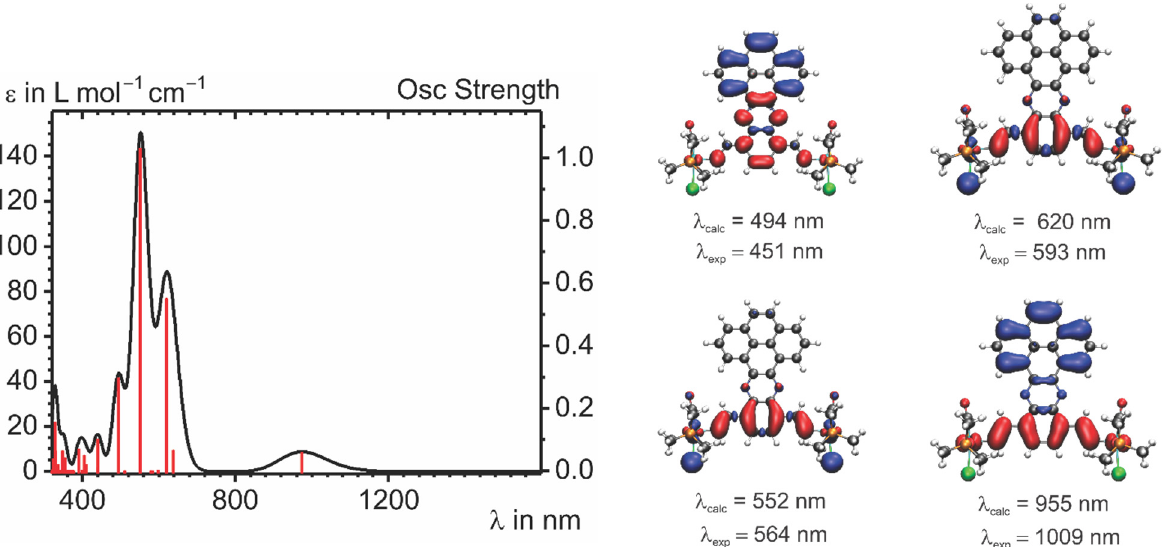
Figure 8. ( Left ): Calculated UV–vis–NIR spectrum of the model complex [ Me Ru 2 -3] • + obtained from the TD-DFT calculations. ( Right ): Electron density difference maps (EDDMs) for the four main electronic transitions in the visible–near UV. The red colour marks an increase and blue colour marks a decrease of electron density during the corresponding electronic transition.